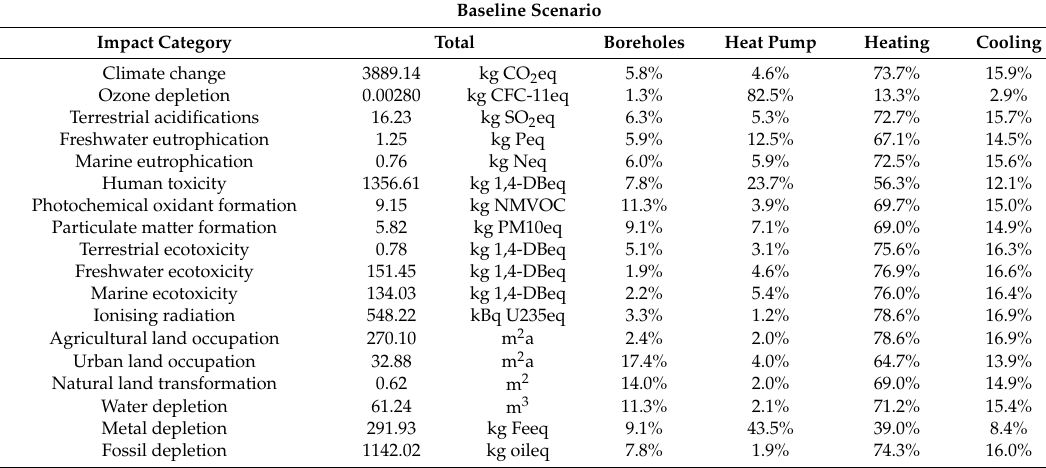
Table 4. Midpoint impact indicators of the baseline scenario.